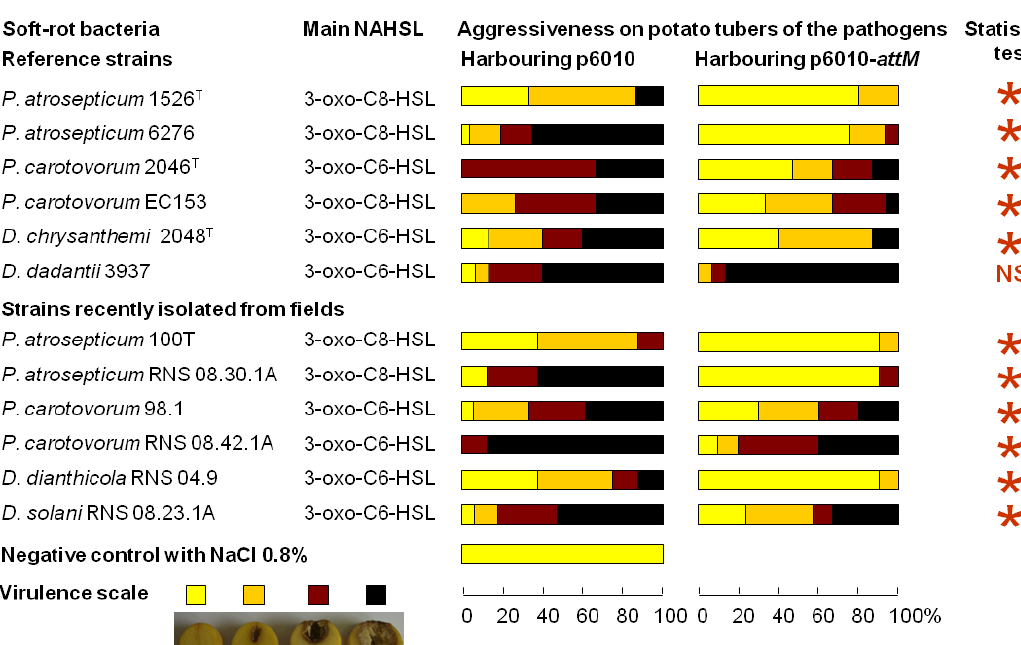
Figure 3. Involvement of NAHSLs in the virulence symptoms on potato